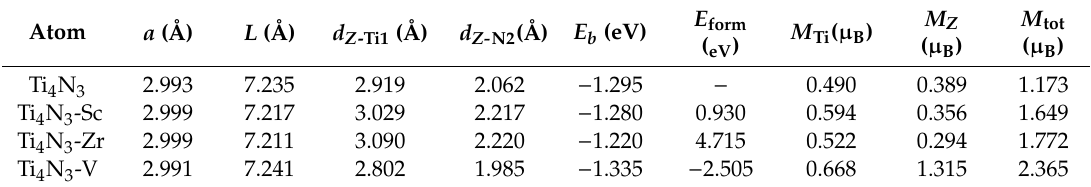
Table 3. Calculated lattice constants a , atomic layer thickness L , binding energy E b , forming energy E form , total magnetic moment M tot , magnetic moment of Z atom or its neighbor Ti atom at the surface, bond length between the doping Z atom at surface and its neighbor Ti 1 or N 2 atom at the surface or subsurface,